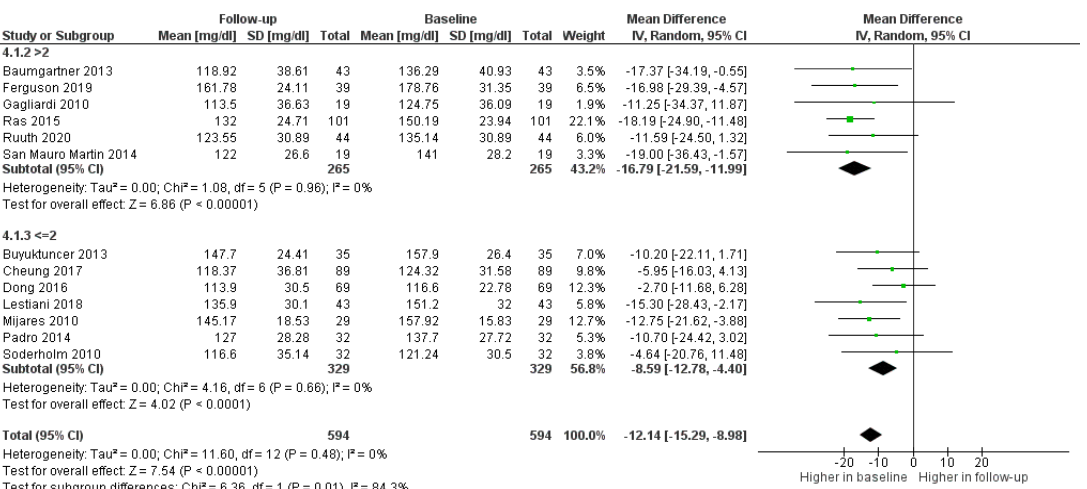
Figure 3. Forest plot comparing baseline and follow up LDL-c among participants in the control/placebo groups.